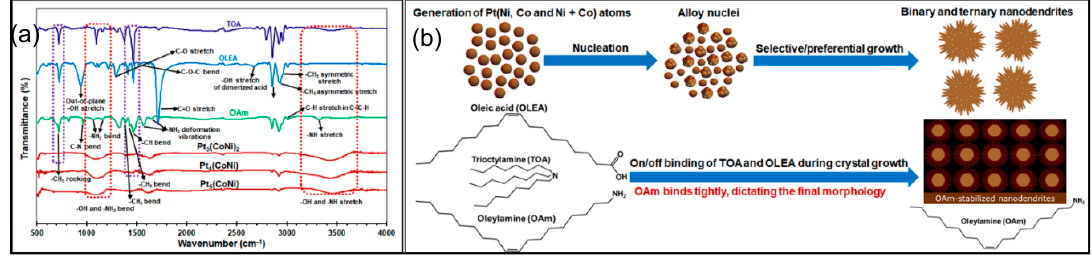
Figure 4. ( a ) FT-IR spectra of surfactants oleylamine (OAm), oleic acid (OLEA), trioctylamine (TOA) and highly-branched nanostructures of Pt 3 (NiCo) 2 , Pt 4 (NiCo) and Pt 5 (NiCo); ( b ) schematic illustration of the proposed crystal growth mechanism of both the binary and ternary nanostructures of Pt with Ni and/or Co, synthesized in the presence of a homogeneous mixture of three surfactants.